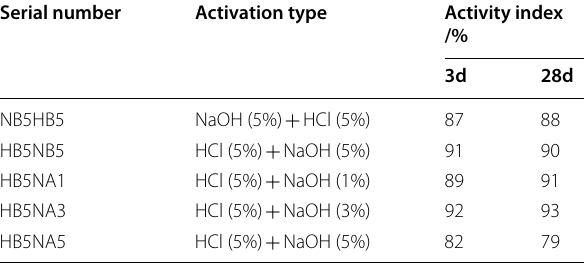
Table 5 Activity index of cement mortar with compound- activated iron tailings